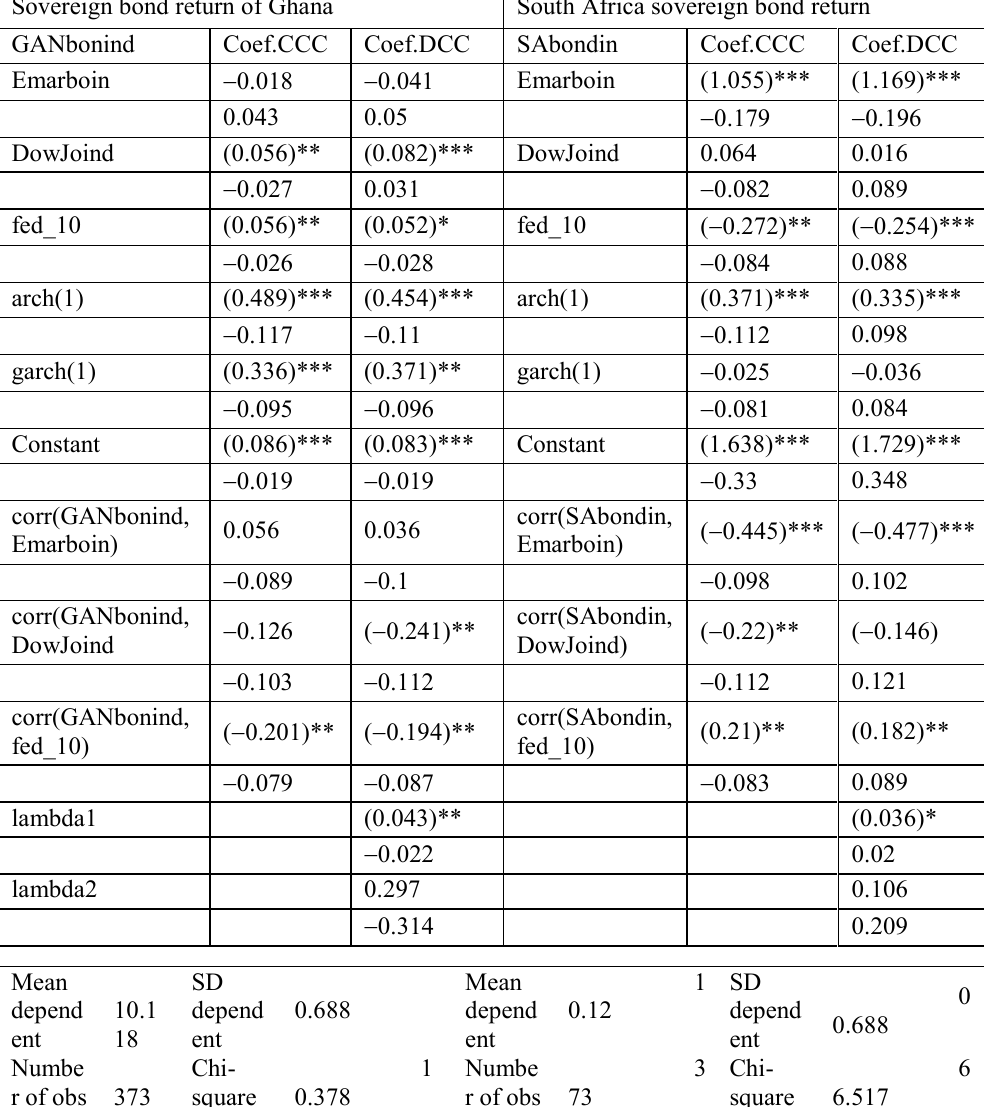
Table 6. Constant and Dynamic Conditional Correlation MGARCH Estimation Sovereign bond return of